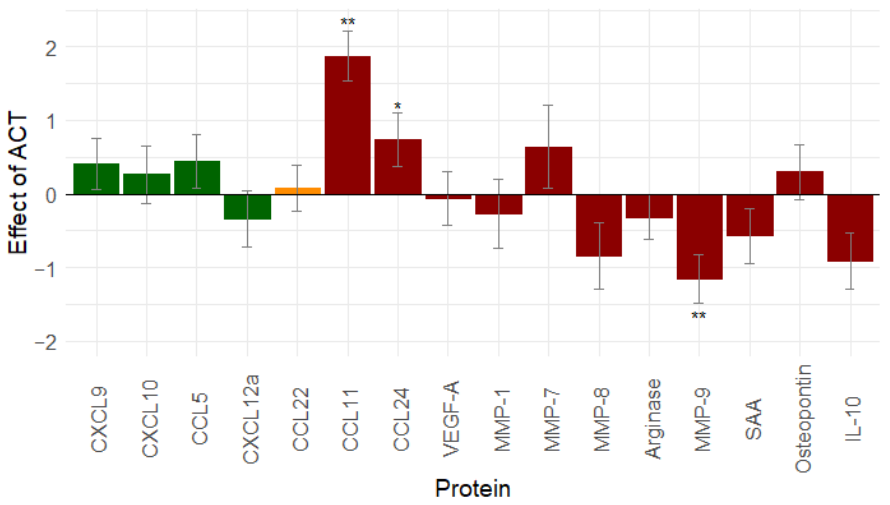
Figure 3. Effect of adjuvant chemotherapy ( n = 66) on immune related proteins: adjuvant chemotherapy shows non-significant increase in immunostimulation and a mixed effect on immunosuppression (similar results are seen when leaving out stage I ovarian cancer patients, see Figure S5). Proteins in green are immune stimulatory factors, proteins in red are immune inhibitory factors, and proteins in orange have a dual function. *: 0.01 ≤ p -value < 0.05; **: p -value < 0.01. Abbreviations: CCL, C-C motif chemokine ligand; CXCL, C-X-C motif chemokine ligand; IL-10, interleukin-10; MMP, matrix metallopeptidase; ACT, adjuvant chemotherapy; SAA, serum amyloid A; vascular endothelial growth factor